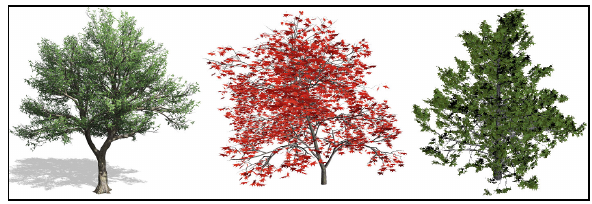
Figure 3. Comparison of three tree object models. SpeedTree (left), XFrog (centre), natFX